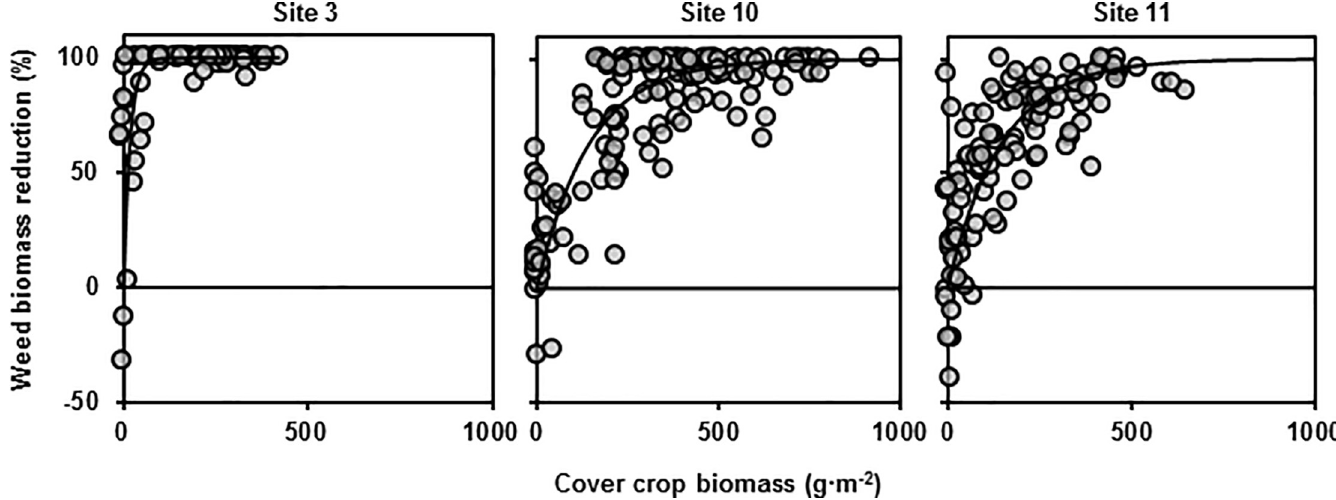
Fig 3. Effect of cover crop productivity on weed biomass reduction. Weed biomass reduction versus cover crop biomass at each of three sites. Exponential equation (Table 5) fit through each of the three data sets. Three data points with cover crop biomass beyond 1000 g m -2 not shown. https://doi.org/10.1371/journal.pone.0206195.g003 PLOS ONE | https://doi.org/10.1371/journal.pone.0206195 March 14,